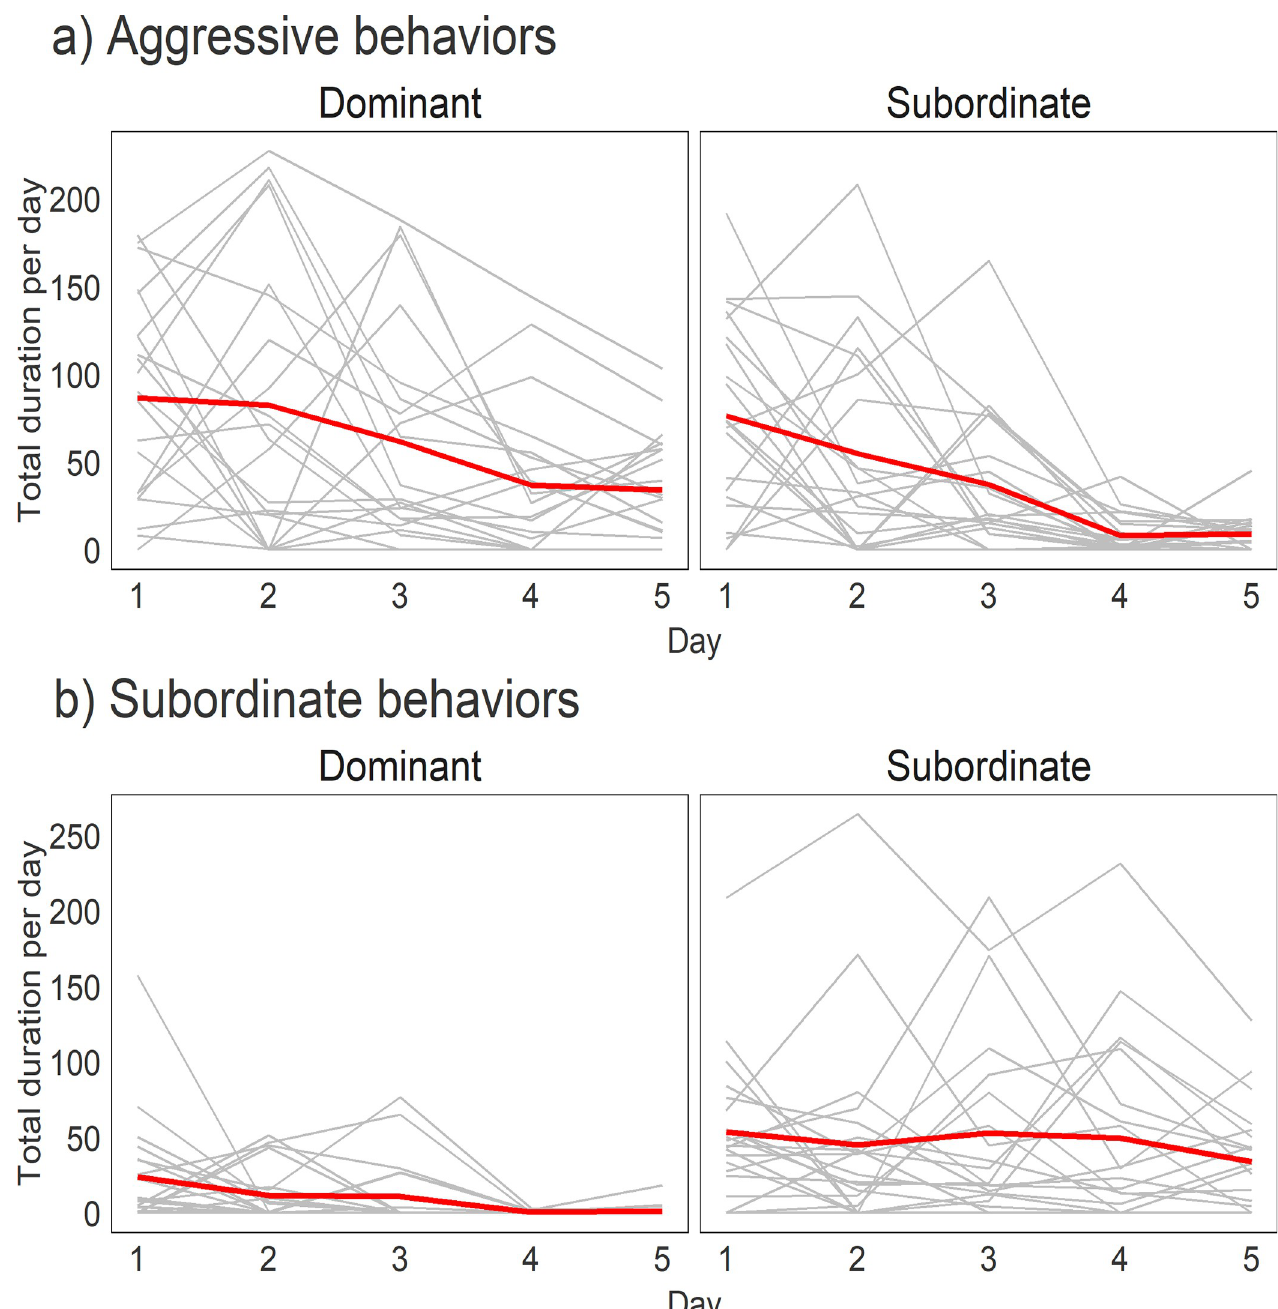
Fig 1. Duration of aggressive and subordinate behaviors of eventual dominant and subordinate individuals across 5 days. Grey lines represent each individual and red lines represent mean duration of each group.